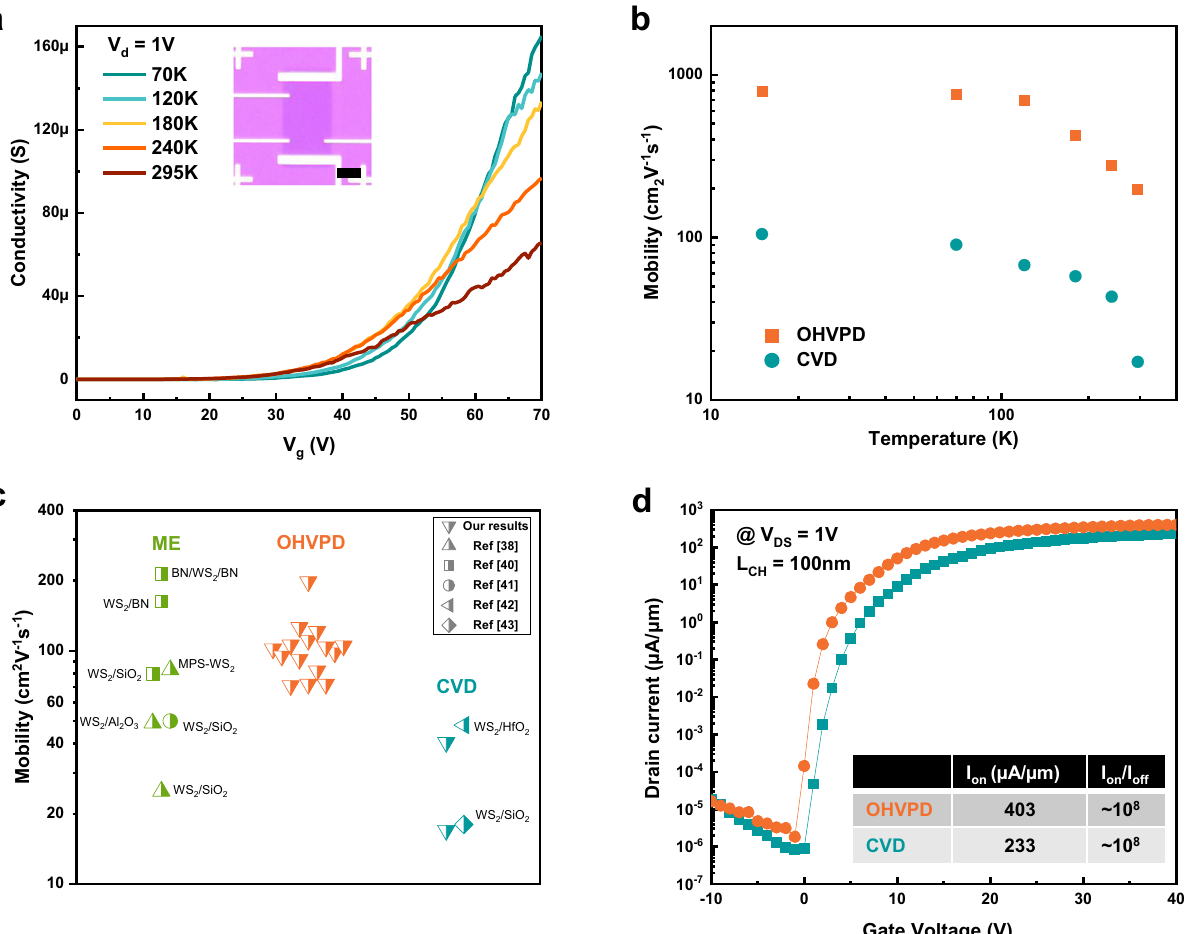
Fig. 4 Electrical performance of OHVPD-WS 2 monolayers. a Four-probe conductivity as a function of Vg for OHVPD-WS 2 monolayer device on the 300 nm SiO x substrate at different temperatures. Insect shows the device structure. (Scale bar: 5 μ m) b Field-effect mobility as a function of temperature for OHVPD- and CVD-WS 2 monolayers. c Comparison of mobility distribution for our OHVPD-WS 2 results (orange), mechanical exfoliation WS 2 monolayers (ME, green), and conventional CVD-WS 2 (cyan) from literatures. d FET transfer curve of an OHVPD-WS 2 monolayer for the short channel device (L CH = 100